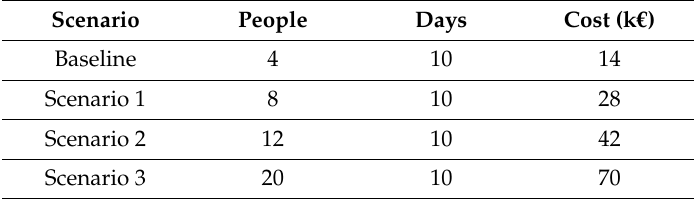
Table 9. Mobilisation and demobilisation costs for the different